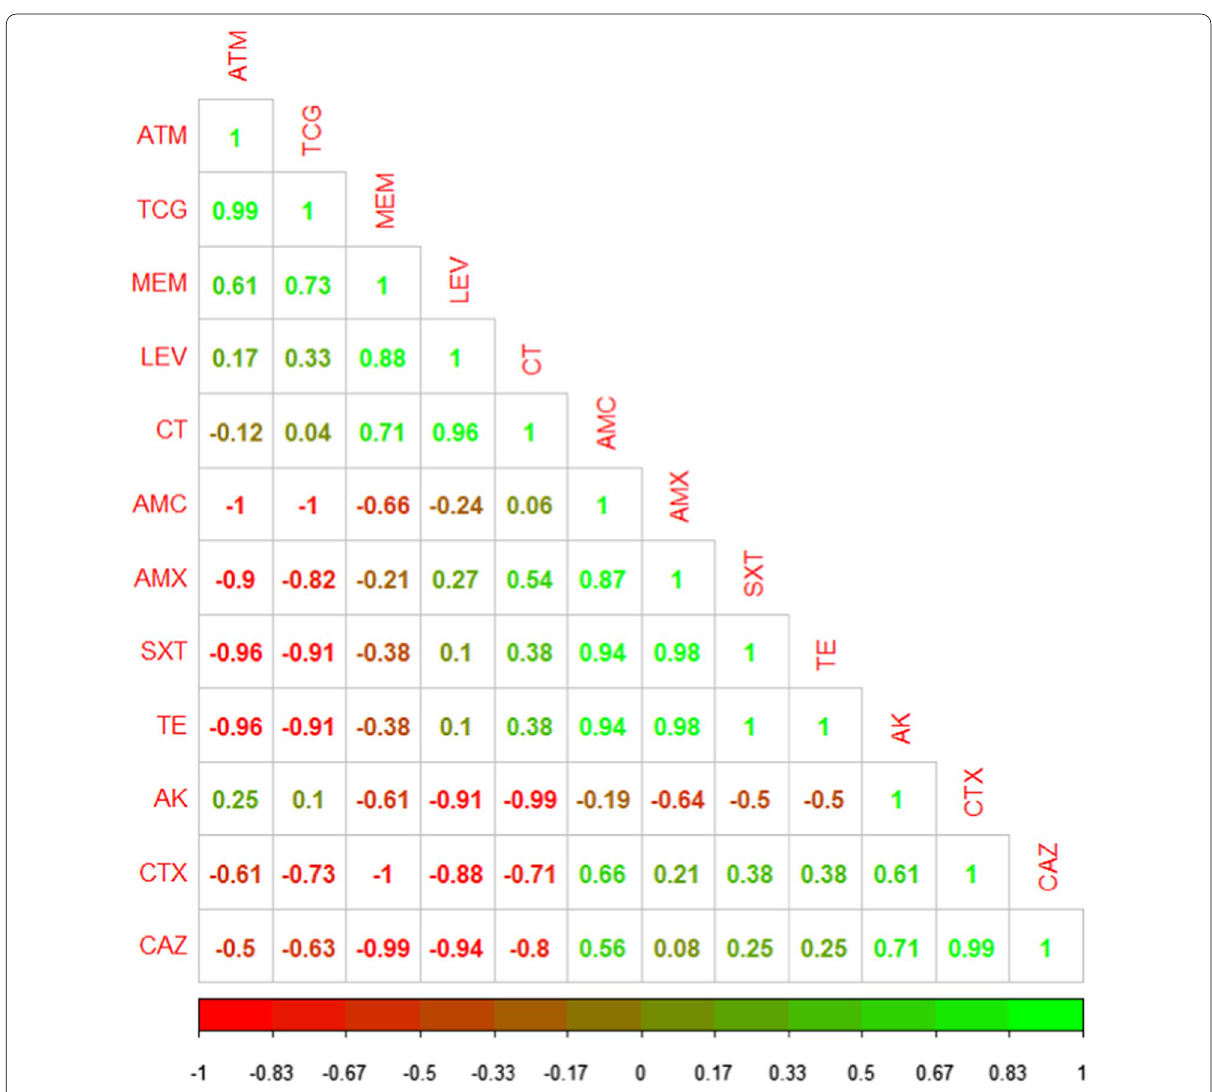
Fig. 2 The heat map describes the correlation among different antimicrobial